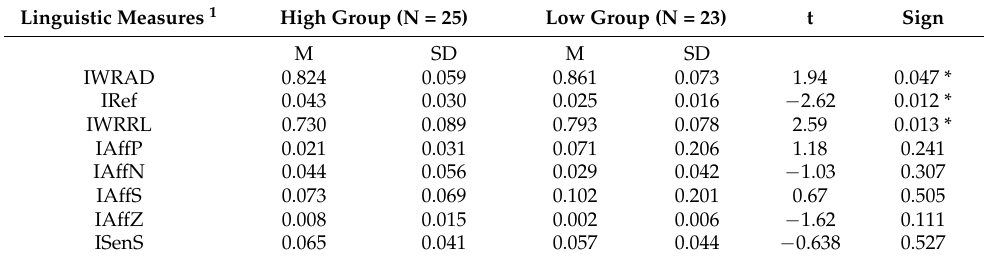
Table 3. Differences in linguistic measures among two groups of SCL-90-R scores, the high group and low group. Linguistic Measures